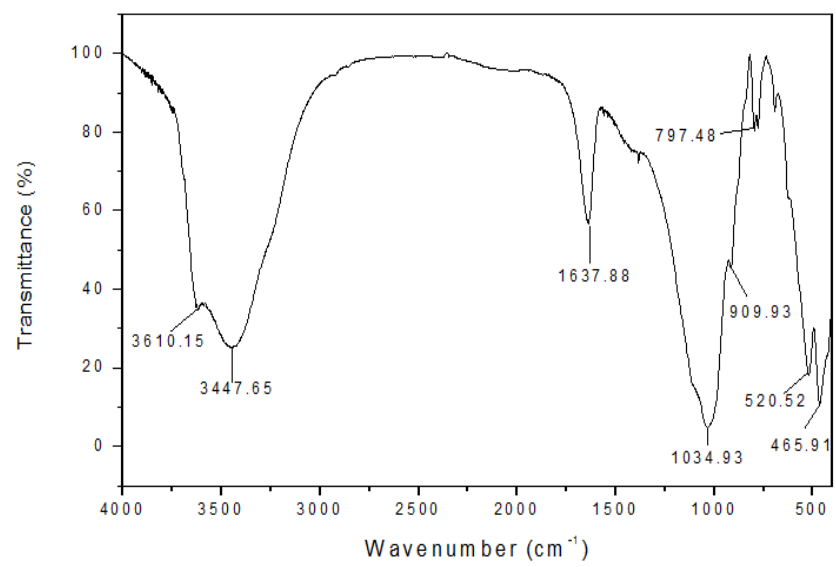
Figure 2. Infrared spectrogram of sodium bentonite for laboratory evaluation.